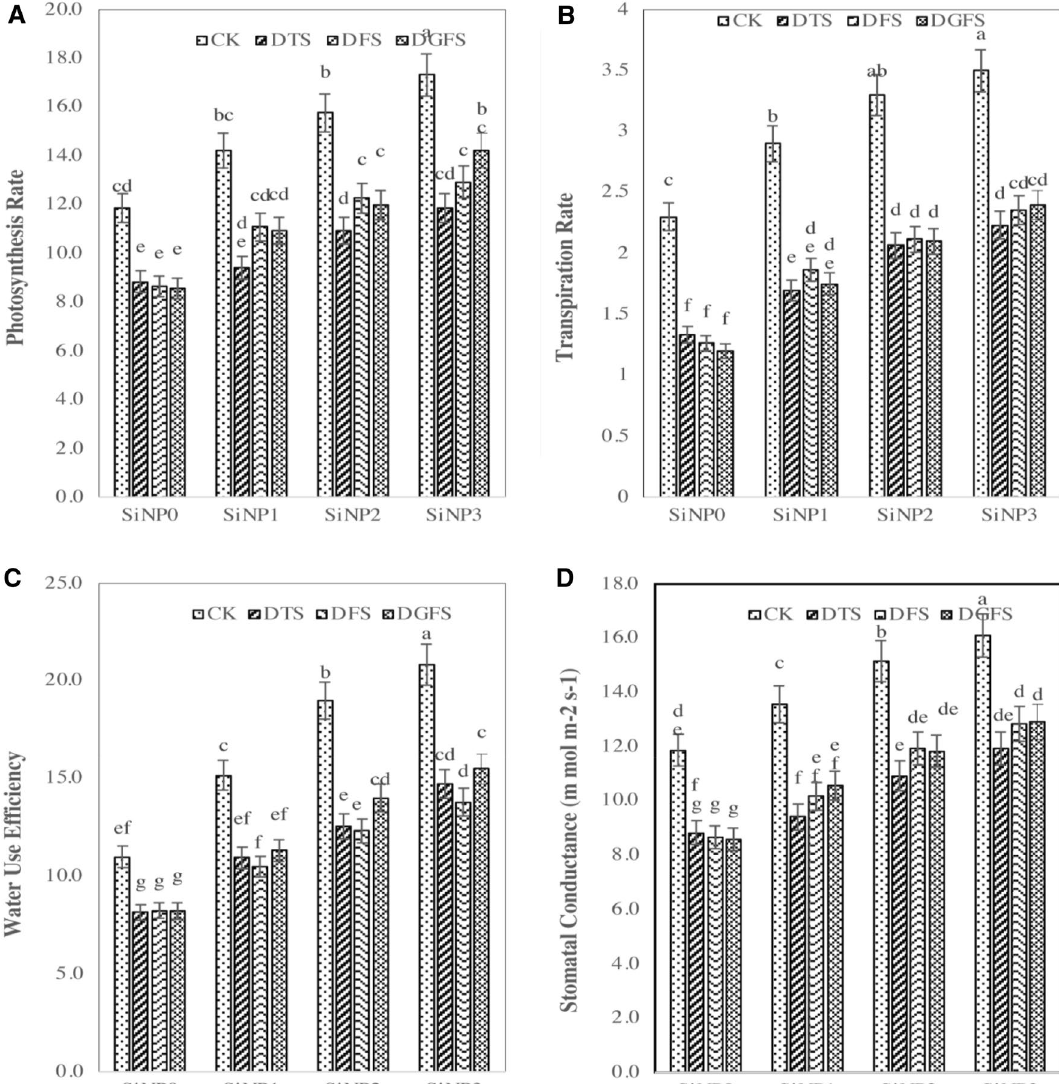
Figure 3. Photosynthesis rate (Pr, A ), transpiration rate (Tr, B ), Water use efficiency (WUE, C ), and stomatal conductance (SC, D ) contents affected by Si-NPs application (0, 300, 600, and 900 mg/L) under drought